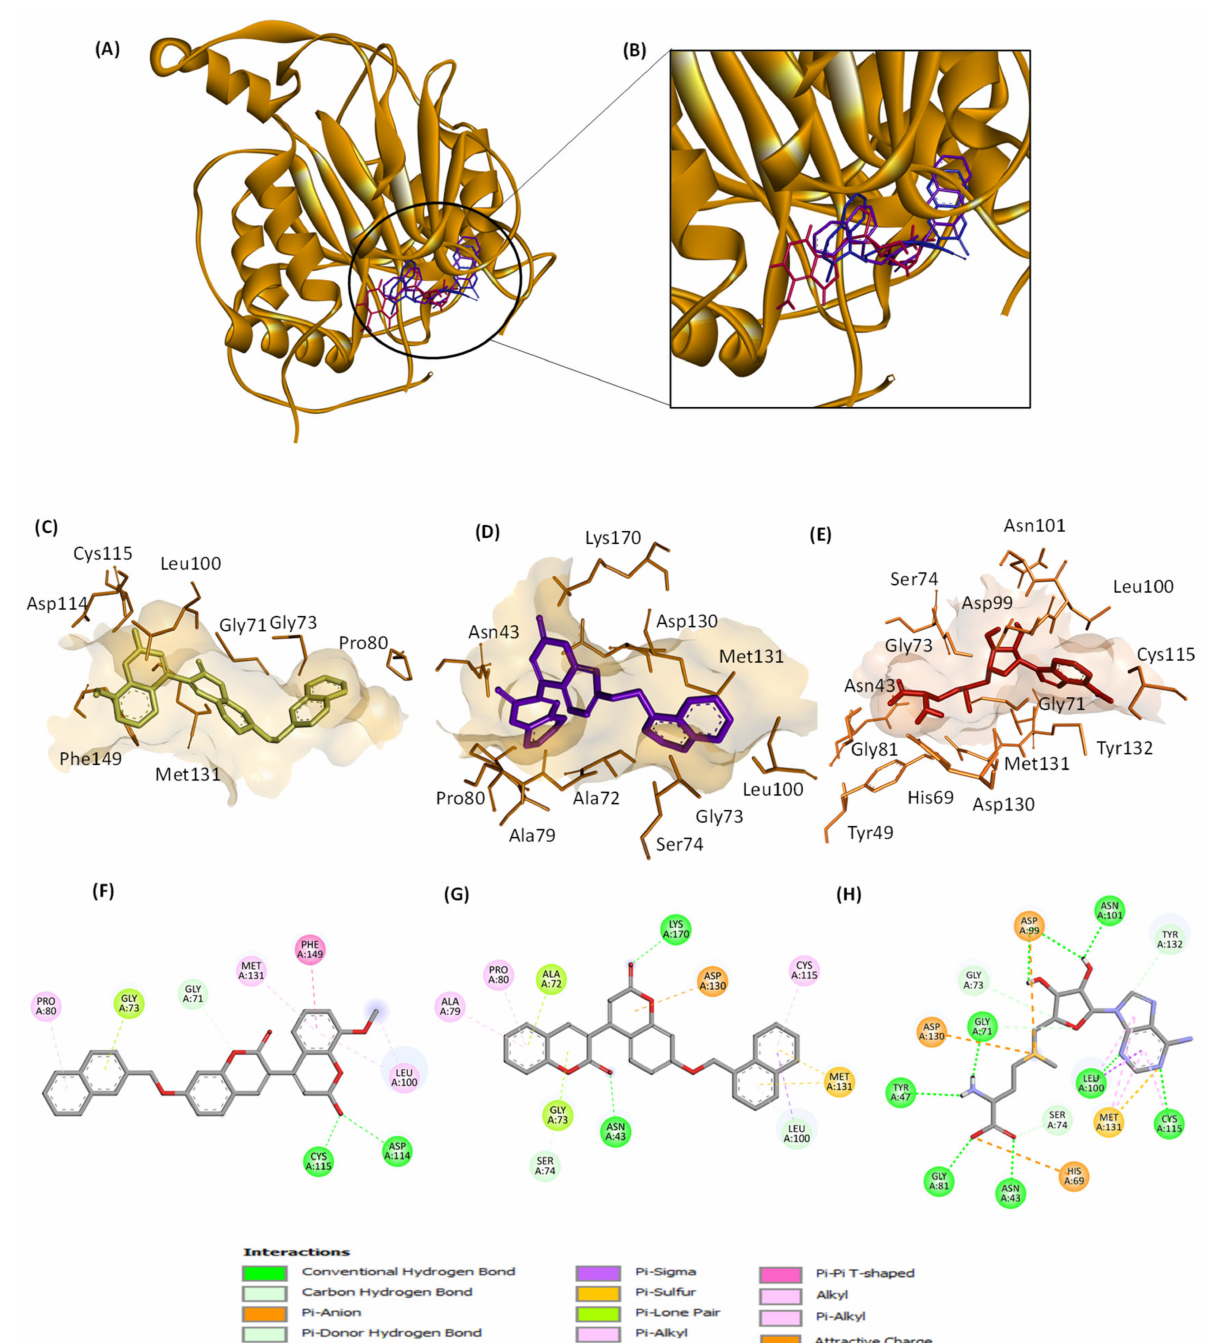
Figure 7. 3D and 2D views of the interactions of the hit molecules with MERS-CoV nsp16 binding pocket (PDB: 5YN6) determined by molecular docking. ( A ) Binding of the hits and the control SAM. ( B ) Zoomed view of the 3D structure of MERS-CoV nsp16. ( C – E ): interactions of the amino acids in the binding pocket with ZINC12880820 (gold), ZINC2129028 (purple), and the control SAM (red), respectively. ( F – H ) are 2D views of ( C – E ), respectively. The images were generated by Discovery Studio